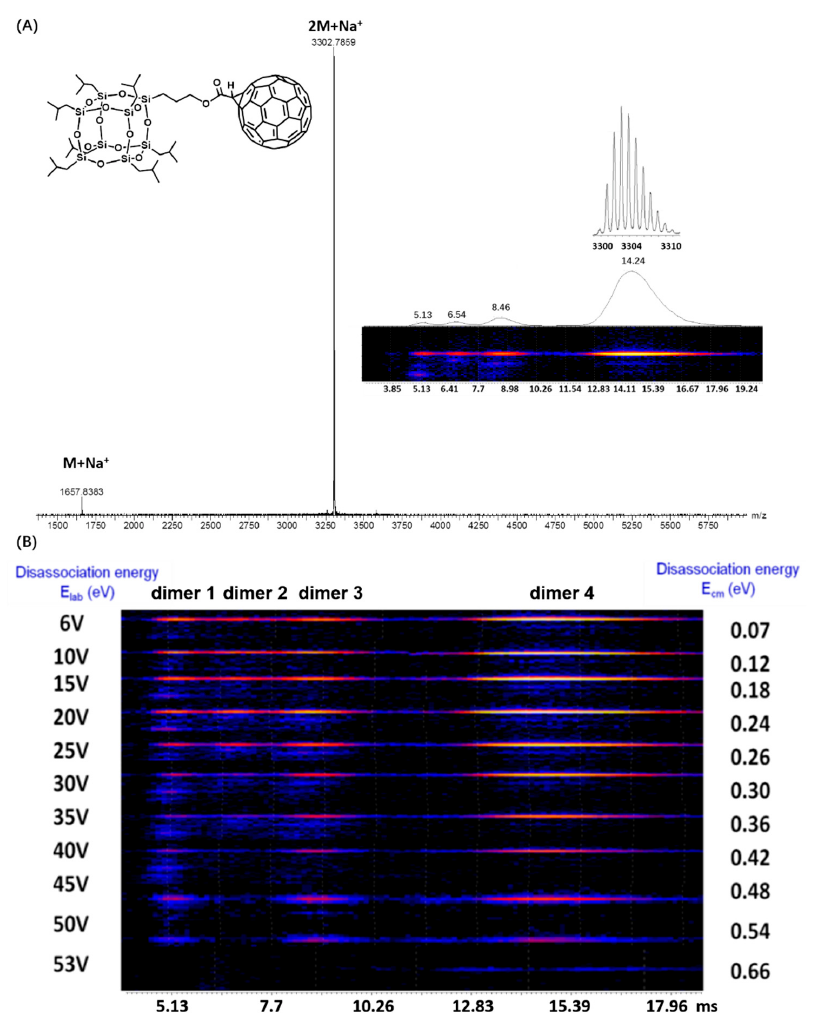
Figure 3. ( A ) ESI mass spectrum of BPOSS-C 60 . ( B ) Two-dimensional ESI-TWIM-MS plot of BPOSS-C 60 for m / z 3302.78 showing di ff erent types of dimers. The calculated molecular weight of BPOSS-C 60 associated with Na + is 1657.28